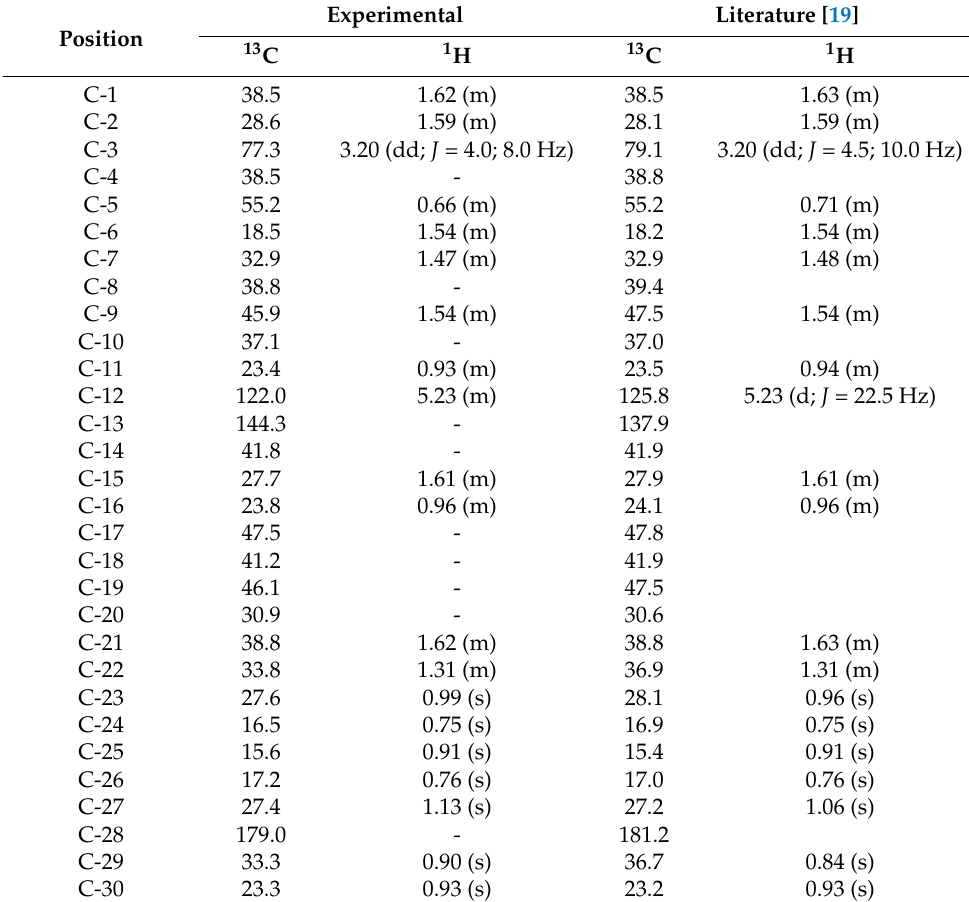
Table 1. Experimental 13 C and 1 H NMR data for compound 1 and data from the literature. Experimental Literature [19] Position 13 C 1 H 13